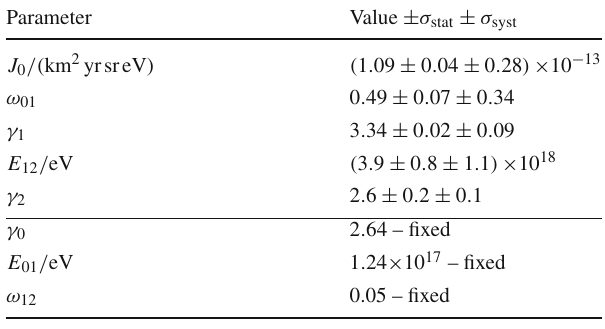
Fig. 12 UnfoldedenergyspectrumderivedusingdatafromtheSD-750 array